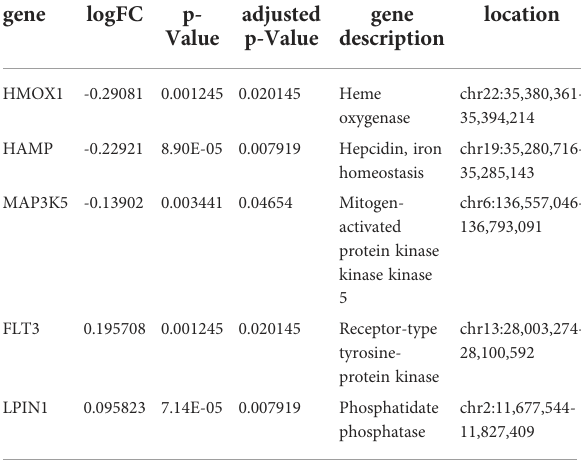
Table 1 Basic information of these fi ve